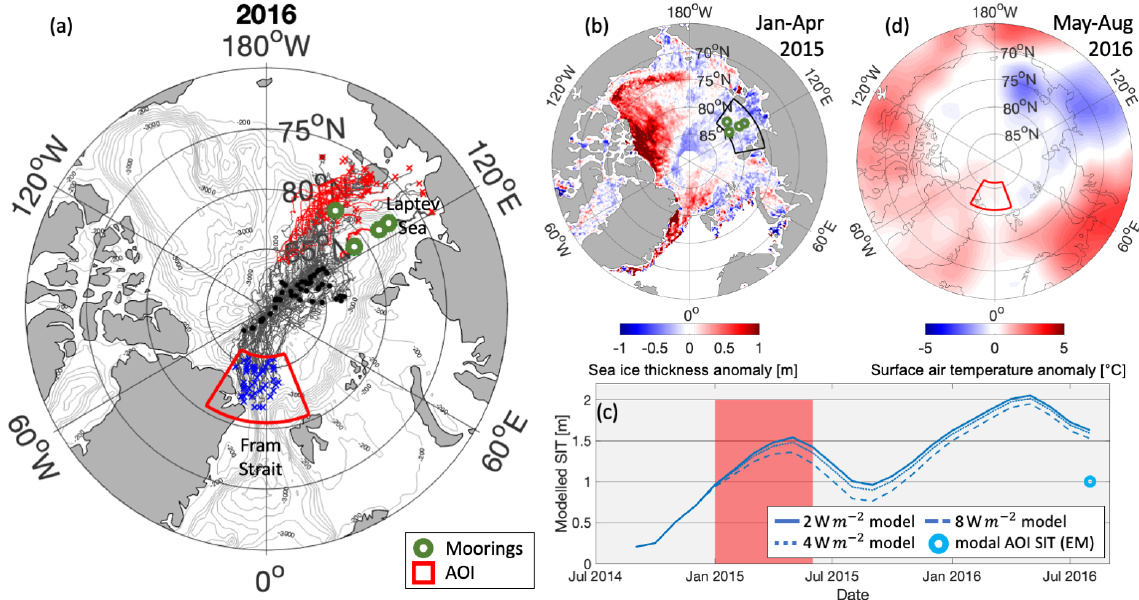
Figure 4. (a) Drift trajectories of AOI-sampled (enclosed area) sea ice in 2016. Starting points for the backtracking (blue crosses) correspond to the positions where EM SIT measurements were conducted during July and August 2016. Tracking ended when sea ice concentra- tion dropped to 25% or less, which is defined as time and position of ice formation (red crosses). Black dots present sea ice position on 21 September, when ice particles are considered to have survived the summer, becoming second-year and multi-year ice, respectively. The sections of the trajectories coloured in red indicate sea ice position between January and through May 2015. Green markers indicate the positions of oceanographic moorings operated between summer 2013 and summer 2015 (Polyakov et al., 2017). (b) January to April 2015 SIT anomaly (compared to the January to April mean from 2003 to 2020) from the ESA CCI-2 SIT climate data record (Hendricks et al., 2018a, b). (c) Mean SIT modelled along the drift trajectories of the sea ice sampled in the AOI in 2016. Solid blue line indicates the mean modelled thickness over all trajectories using a constant ocean heat flux value of 2Wm − 2 . Dotted (dashed) blue line shows average mod- elled SIT using 2Wm − 2 ocean heat flux along the black parts of the trajectories (Fig. 3a) and 4Wm − 2 (8Wm − 2 ) along the red parts of the trajectories (shaded red area). Light blue marker indicates the observed modal EM SIT in the AOI in 2016. (d) The 2016 May to August surface air temperature anomaly in comparison to the 2000 to 2019 long-term mean (data source http://www.esrl.noaa.gov/psd/products,